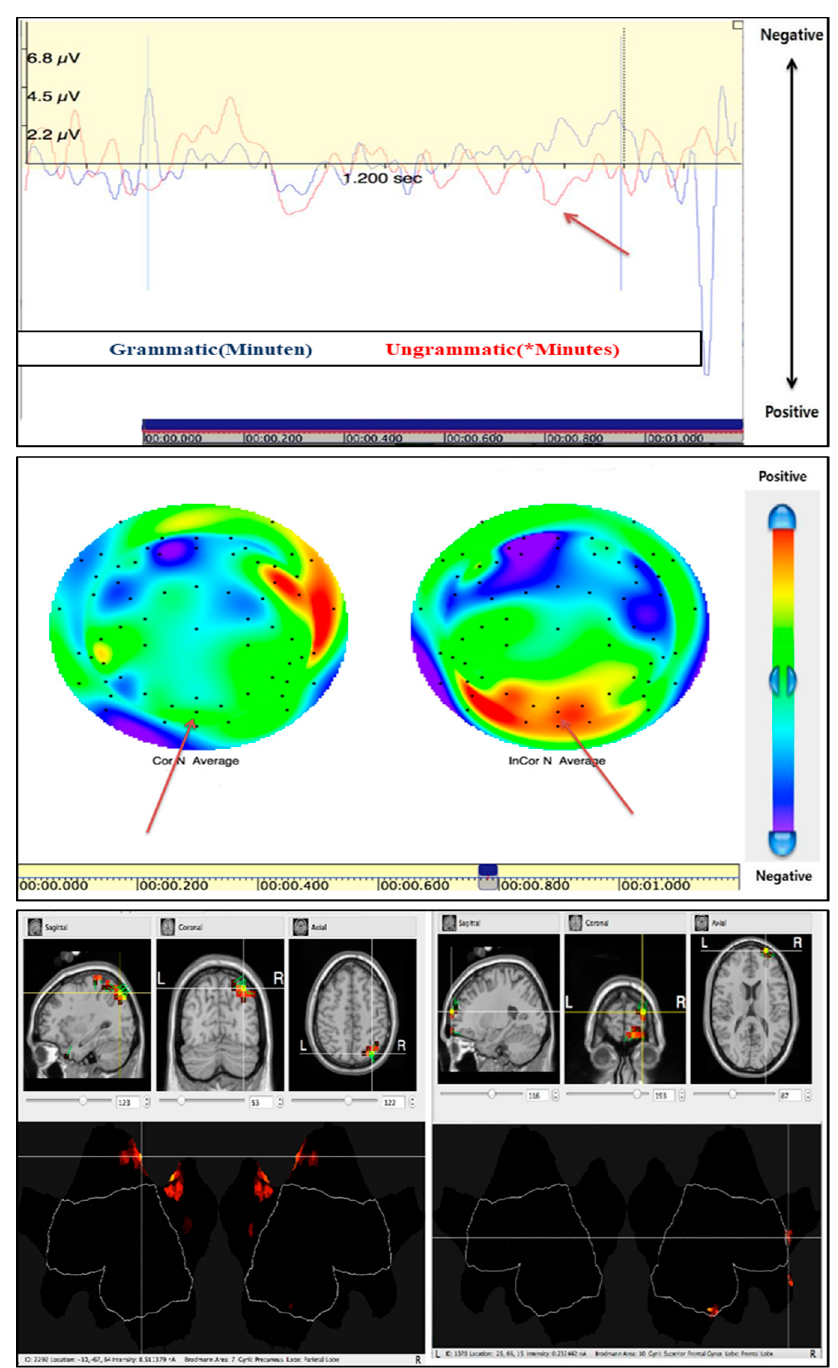
Figure 4. P600 (PZ) by regular ending violation in high L2 learners.